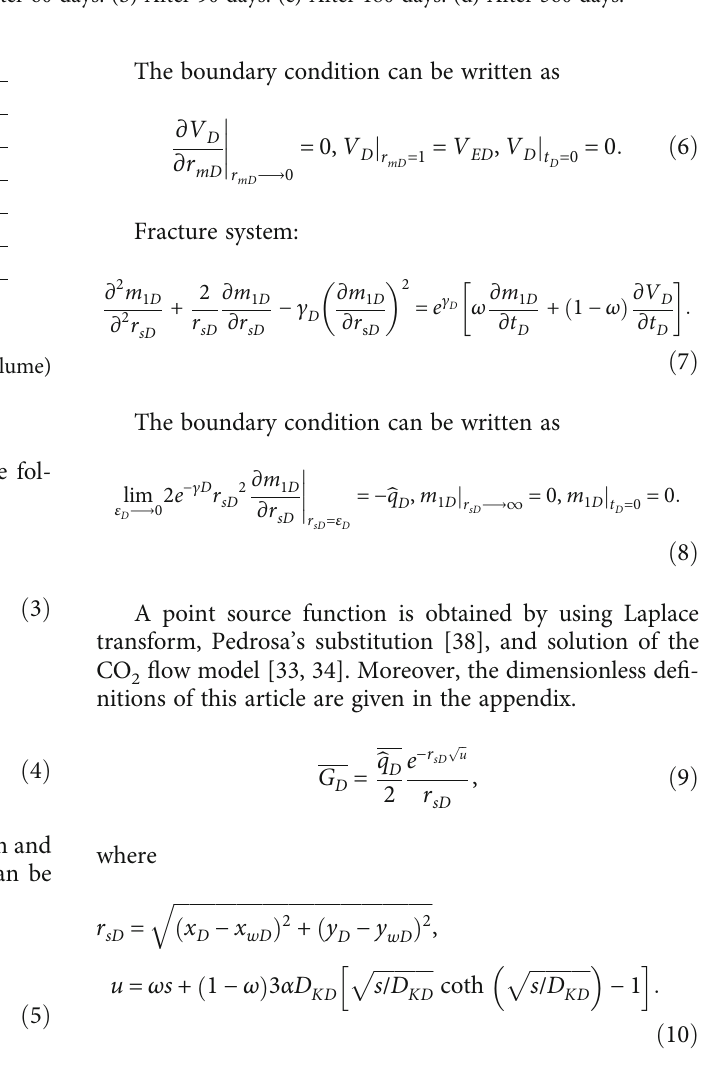
Figure 5: Pressure distribution of the system. (a) After 60 days. (b) After 90 days. (c) After 180 days. (d) After 360 days.